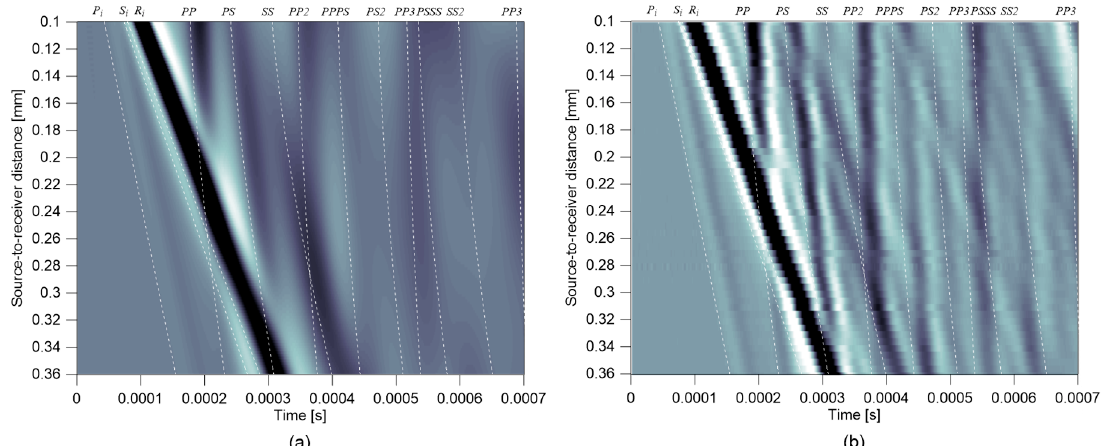
Figure 5. B-scan images representing vertical velocity responses of impact-induced elastic stress waves: ( a ) results from a crack-free FE numerical simulation, and ( b ) results from a Plexiglas specimen measured by a laser vibrometer. The thickness of plates in the FE simulation and experiment in the laboratory was 200 mm.